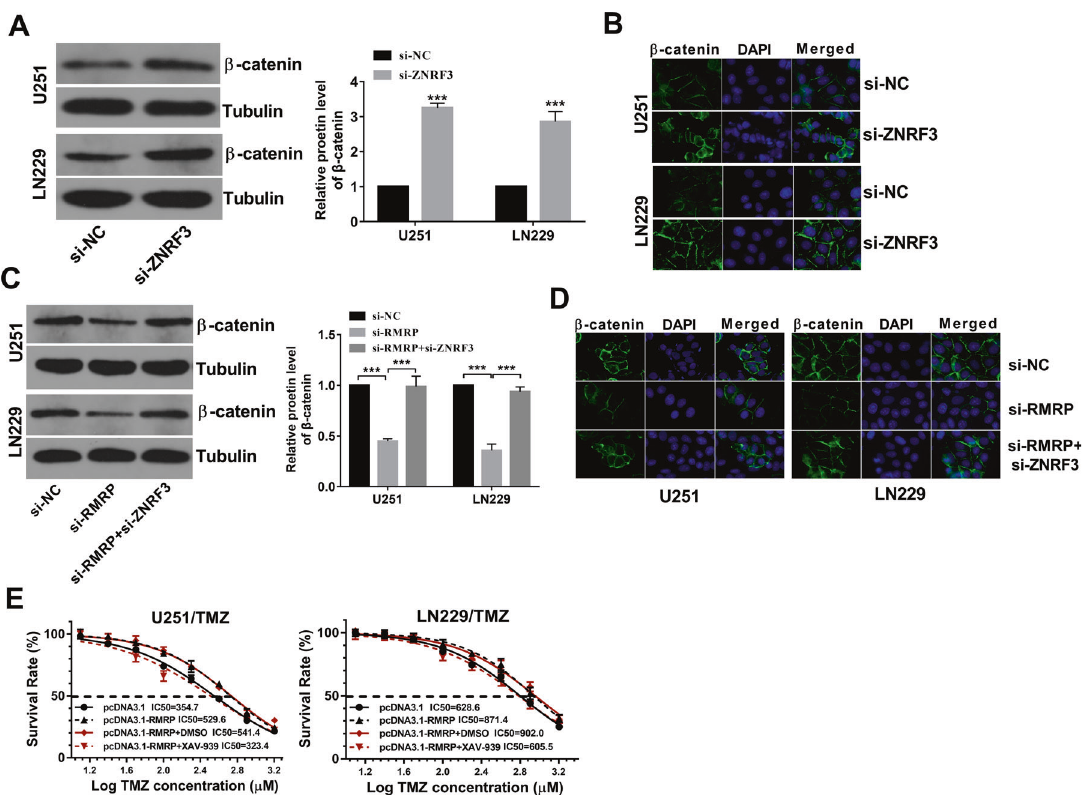
Fig. 7 RMRP knockdown inhibited β -catenin expression by up-regulating ZNRF3 in glioma cells. A , B Cells were transfected with si-NC or si-ZNRF3 for 48 h, followed by the measurement of β -catenin protein level via western blot assay A ( n = 3) and IF assay ( n = 1) B . C , D Cells were transfected with si-NC, si-RMRP, or si-RMRP + si-ZNRF3. At 48 h post-transfection, western blot assay C ( n = 3) and IF assay D ( n = 1) were performed to examine the protein expression pattern of β -catenin. E U251/TMZ and LN229/TMZ cells were transfected with pcDNA3.1 or pcDNA3.1-RMRP for 24 h and then stimulated with or without DMSO/XAV-939 (10 µM) and different doses of TMZ for 24 h, followed by the measurement of TMZ IC 50 values via CCK-8 assay ( n =